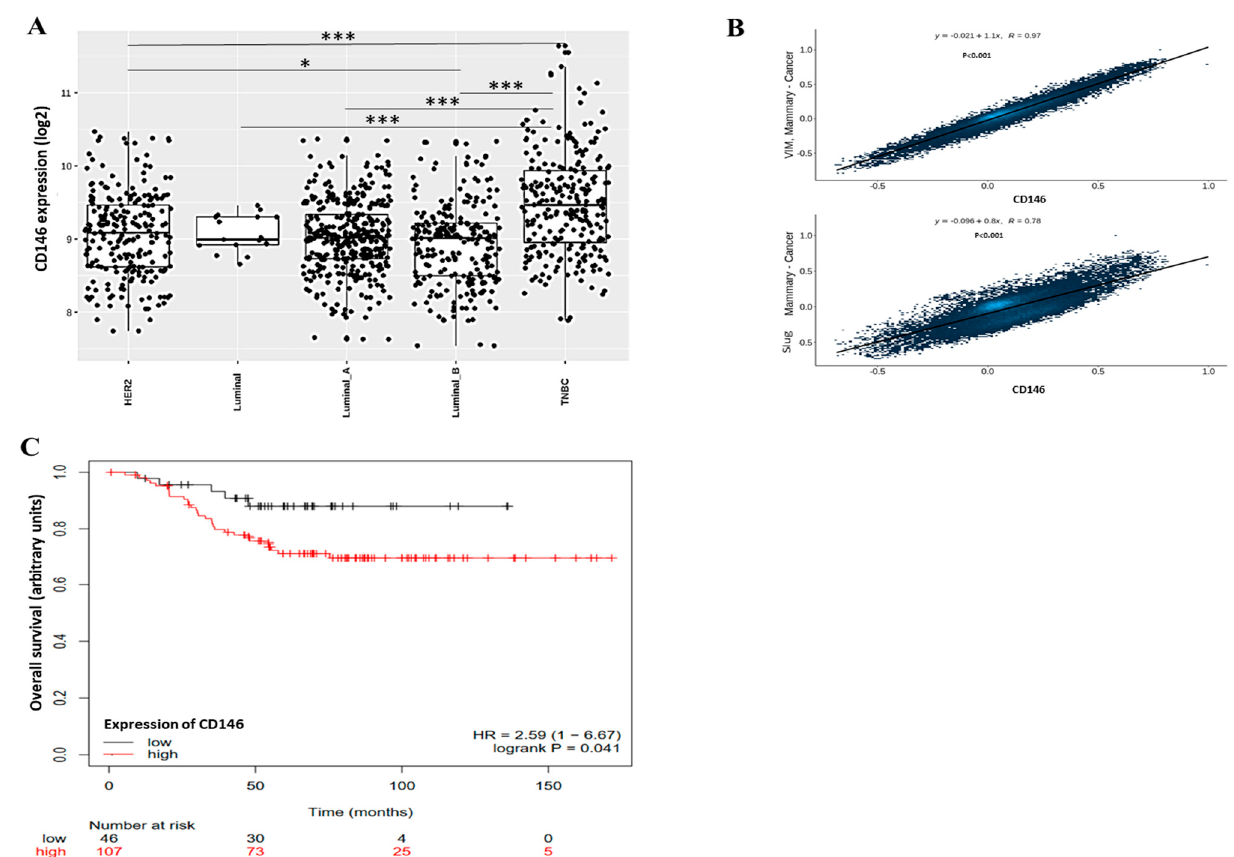
Figure 8. Expression of CD146, correlation with EMT markers and effect on overall survival in patients with breast cancer using public databases. ( A ) CD146 expression was determined in different subtypes of breast cancer, including HER2 cancer, luminal cancer and Triple Negative Breast Cancer (TNBC). Data were analyzed using gent2 in silico tool (http://gent2.appex.kr/gent2; 12 November 2021). ( B ) Expression of EMT markers (Vimentin and Slug) were correlated with CD146 expression in patients with breast cancer. Data were obtained from GitHub repository using correlation AnalyzeR (https://gccri.bishop-lab.uthscsa.edu/shiny/correlation-analyzer; 12 November 2021). ( C ) Overall survival of 153 patients with TNBC was given as a function of the low or high expression of CD146. Data were from the TCGA dataset and analyzed using Kaplan–Meier Plotter tool (https://kmplot. com/analysis/index.php?p=service; 12 November 2021). *, ***: p < 0.05, p < 0.001, comparison between breast cancer